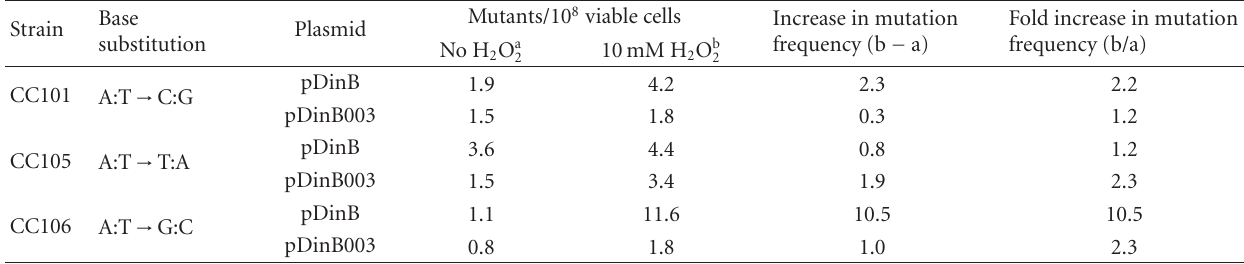
Table 3: Frequencies of mutations to Lac + in E. coli CC101 ∼ CC106 strains with overexpressed dinB gene after incubation with hydrogen